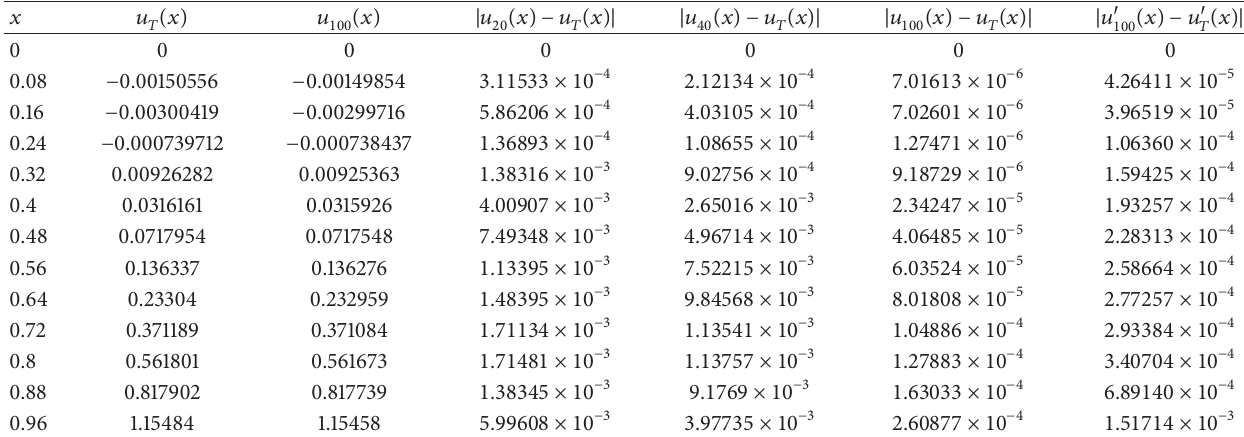
Table 1: The numerical results of Example